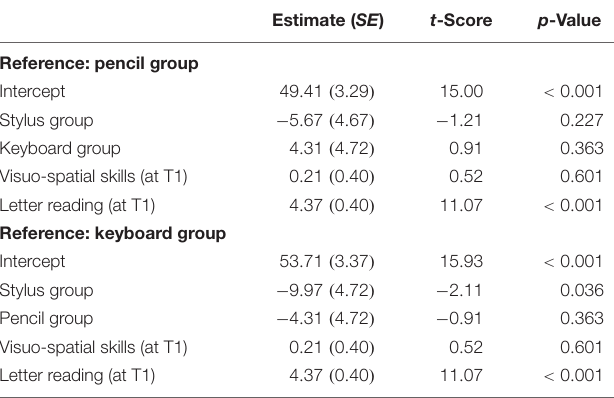
TABLE 6 | Results of estimated regression for the variable word writing to